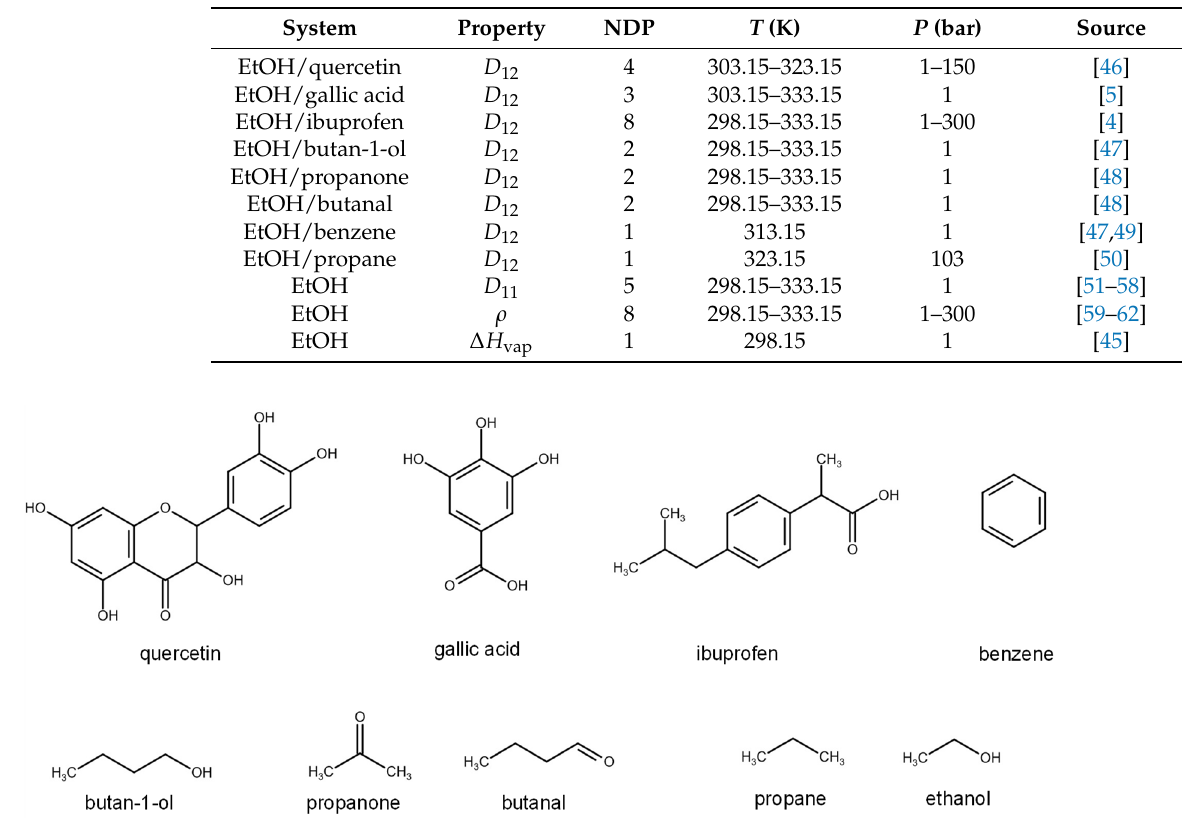
Figure 5. Structural formulas of the compounds studied in this work.